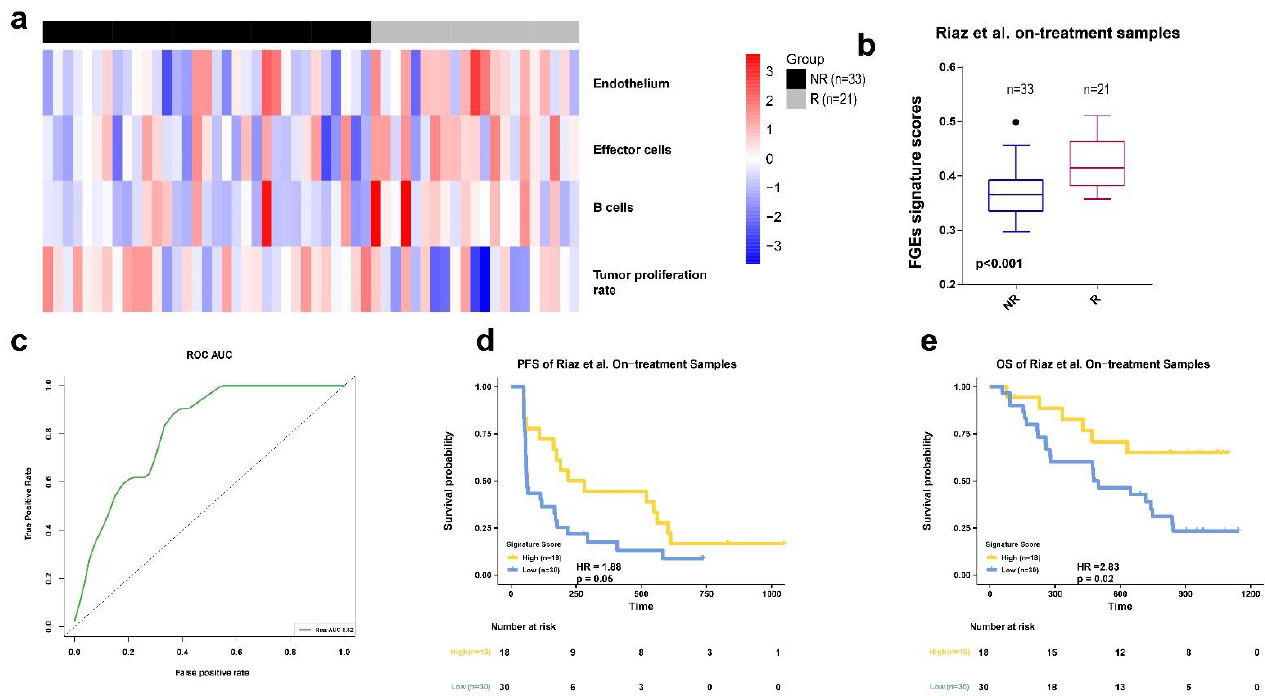
Figure 4. FGE-based signature for on-treatment samples (FGE-ON) ( a ) Heatmap representing the single sample gene set enrichment analysis value of on-treatment nonresponders (NR) and responders (R) in the Riaz et al. cohort. ( b ) Boxplot of FGE-ON signature scores for on-treatment samples from the Riaz et al. datasets. p values were computed via a one-sided Wilcoxon rank-sum test. ( c ) Receiver operating correlation curve and area under the curve of FGE-ON signatures for on-treatment samples from the Riaz et al. cohort. ( d , e ) Kaplan–Meier curves of PFS and OS for on-treatment samples based on FGE-ON signature scores for the Riaz et al. cohort.